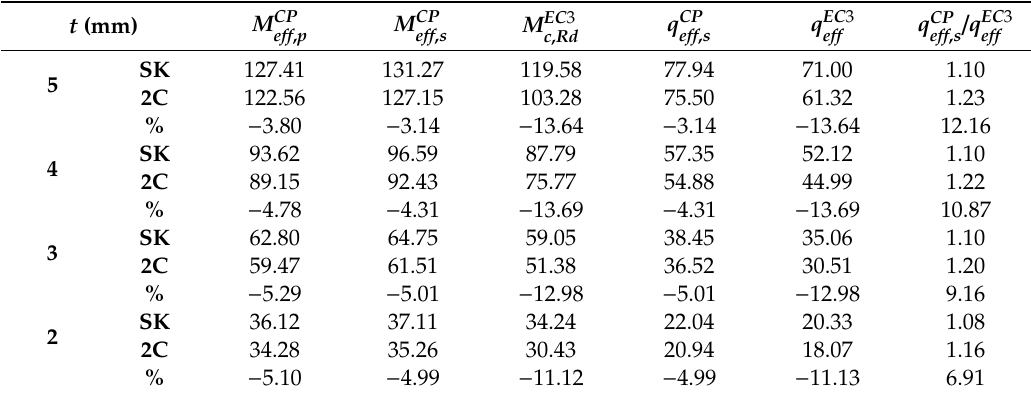
Table 9. Comparison of design ultimate resistances of box sections (Sk) and I-sections (2C) depending on wall